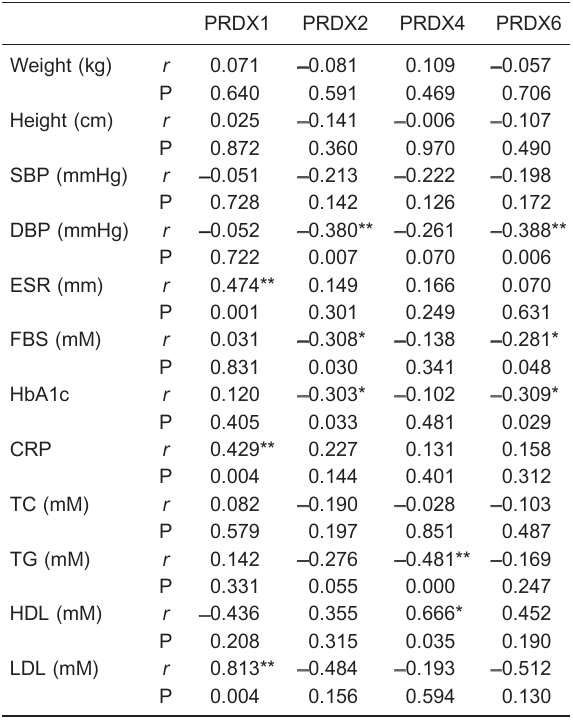
Table 3. Pearson correlations of plasma levels of peroxiredoxin isoforms and other measured variables of all diabetic patients